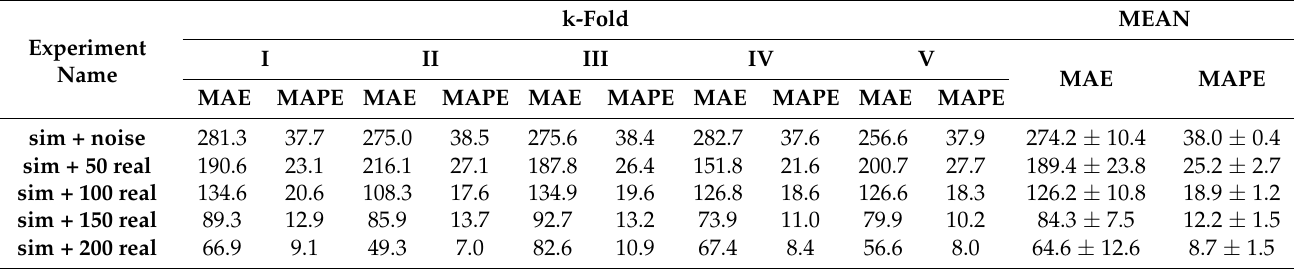
Table 5. MAE/MAPE results reported for best epochs from each of the cross-validation turns. Introducing to the network even a small number of real-world sensor readings resulted in a significant improvement in the